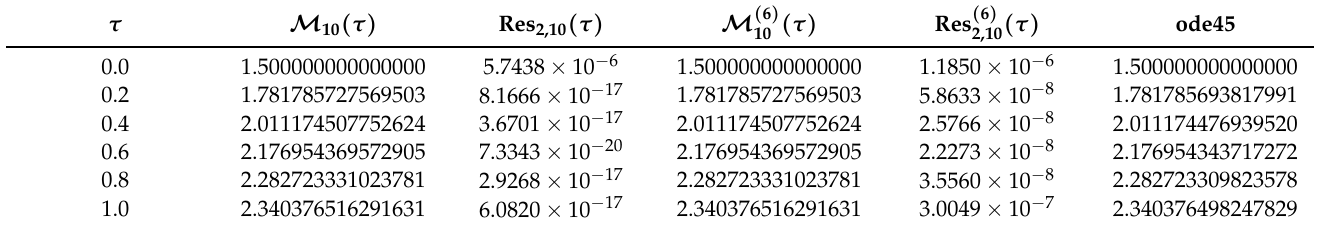
Table 2. The comparison of numerical results for in Test Case 1.